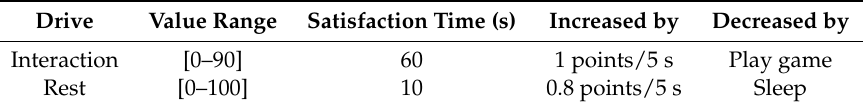
Figure 5. Parametrization and evolution over time of both drives. Interval [a,b) represents the satisfaction time of the drive; [b,c) shows the increase of the drive due to time; [c, d) shows when the drive attains its saturation level; and [d,e) is the satiation of the drive due to the effect of an action ( Play Game for the drive Interaction and Sleeping in the case of the drive Rest ). Table 2. Drives parameters